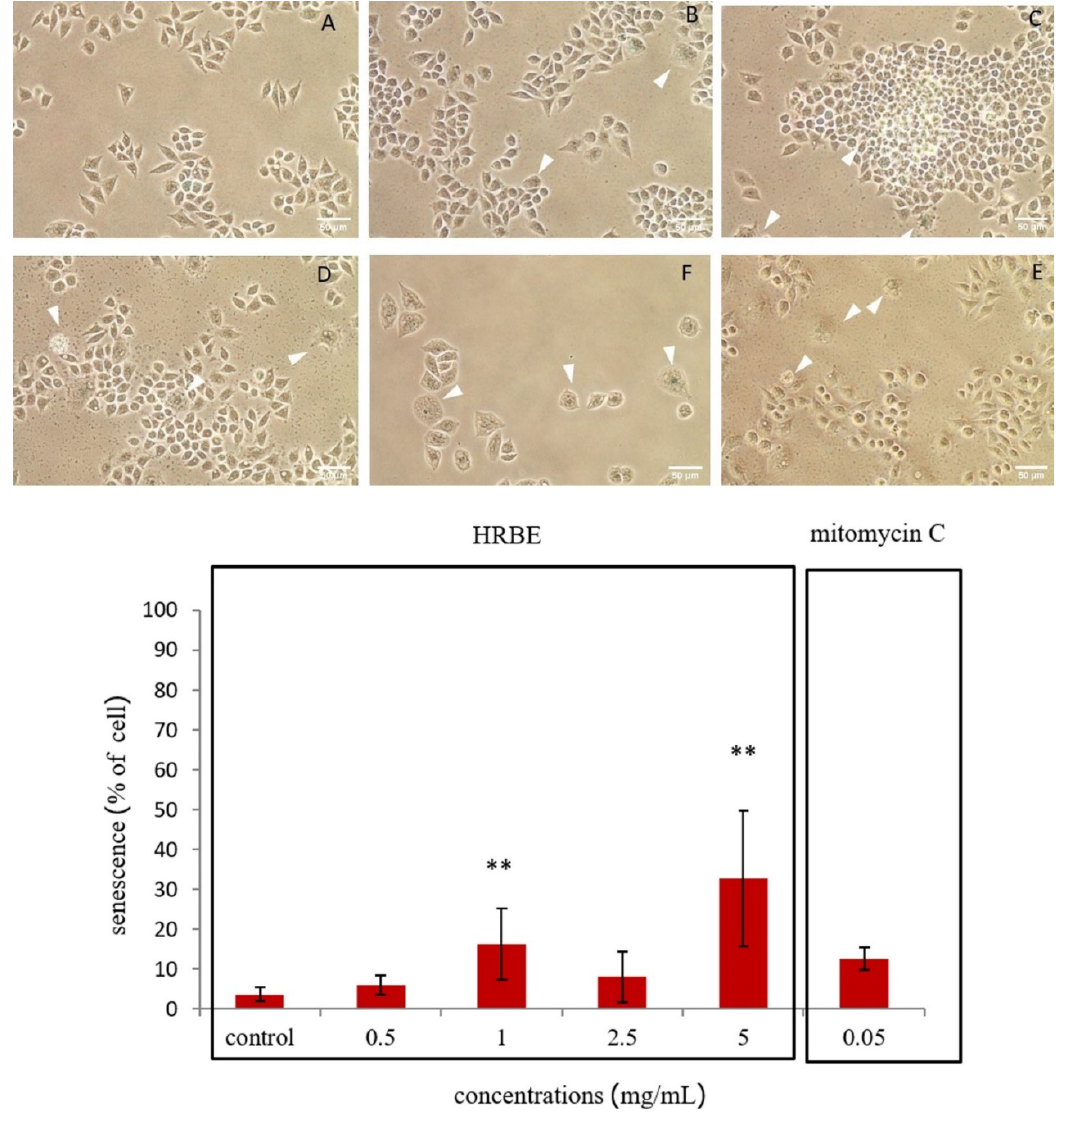
Figure 4. Cellular senescence inducing effect of HRBE on SW-620 cells after being treated with 0 mg/mL, considered as negative control ( A ), 0.5 mg/mL ( B ), 1 mg/mL ( C ), 2.5 mg/mL ( D ) and 5 mg/mL ( E ) for 24 h compared to 0.05 mg/mL mitomycin C treatment, considered as the positive control ( F ). The blue stained cells with flattened and enlarged cell morphology represent the cellular senescence status indicated by the white arrowheads. Data are represented by the mean ± SD. Sta- tistical analysis was performed using student’s t -test comparing each concentration with the control group (0 mg/mL) ( **, p ≤ 0.01).